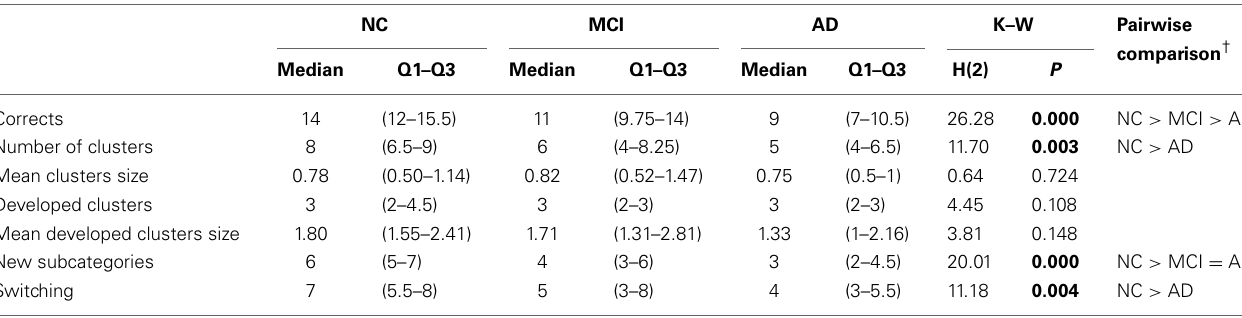
Table 2 | Verbal fluency measures description of NC, MCI, and AD